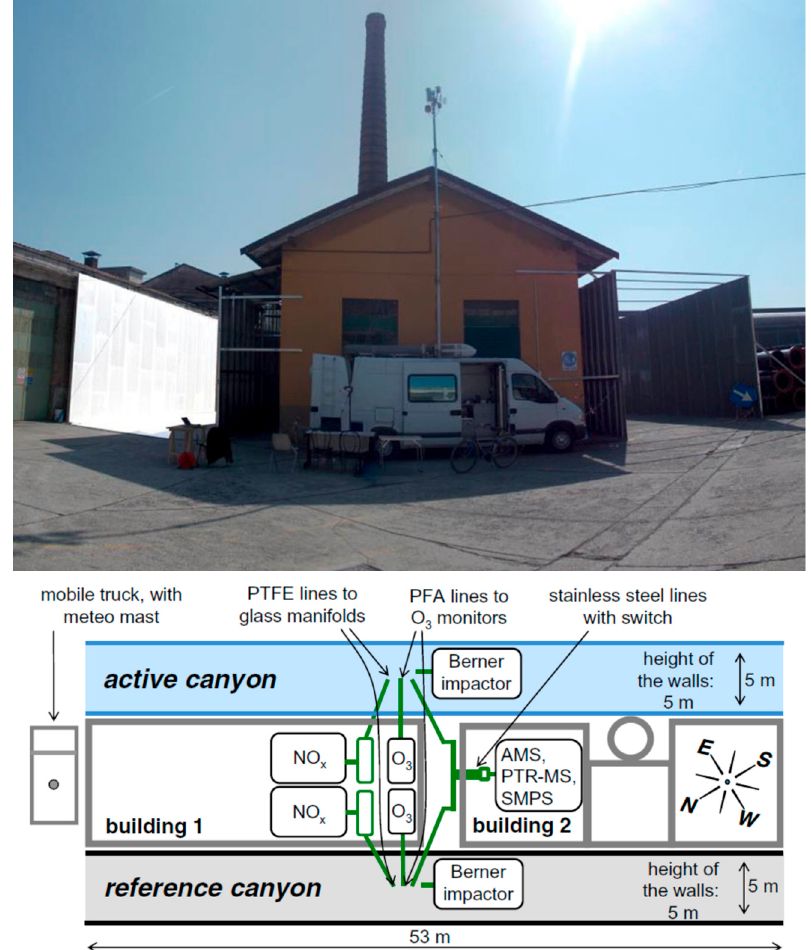
Figure 56. Image and schematic of the two artificial model street (reference and active) canyons with dimensions 5 × 5 × 53 m (width × height × length) at an Italcementi industrial site in Petosino near Bergamo, Italy. Reproduced with permission from Gallus et al. [15]. Copyright 2015 by Springer-Verlag Berlin Heidelberg (License No.: 4453120887380).